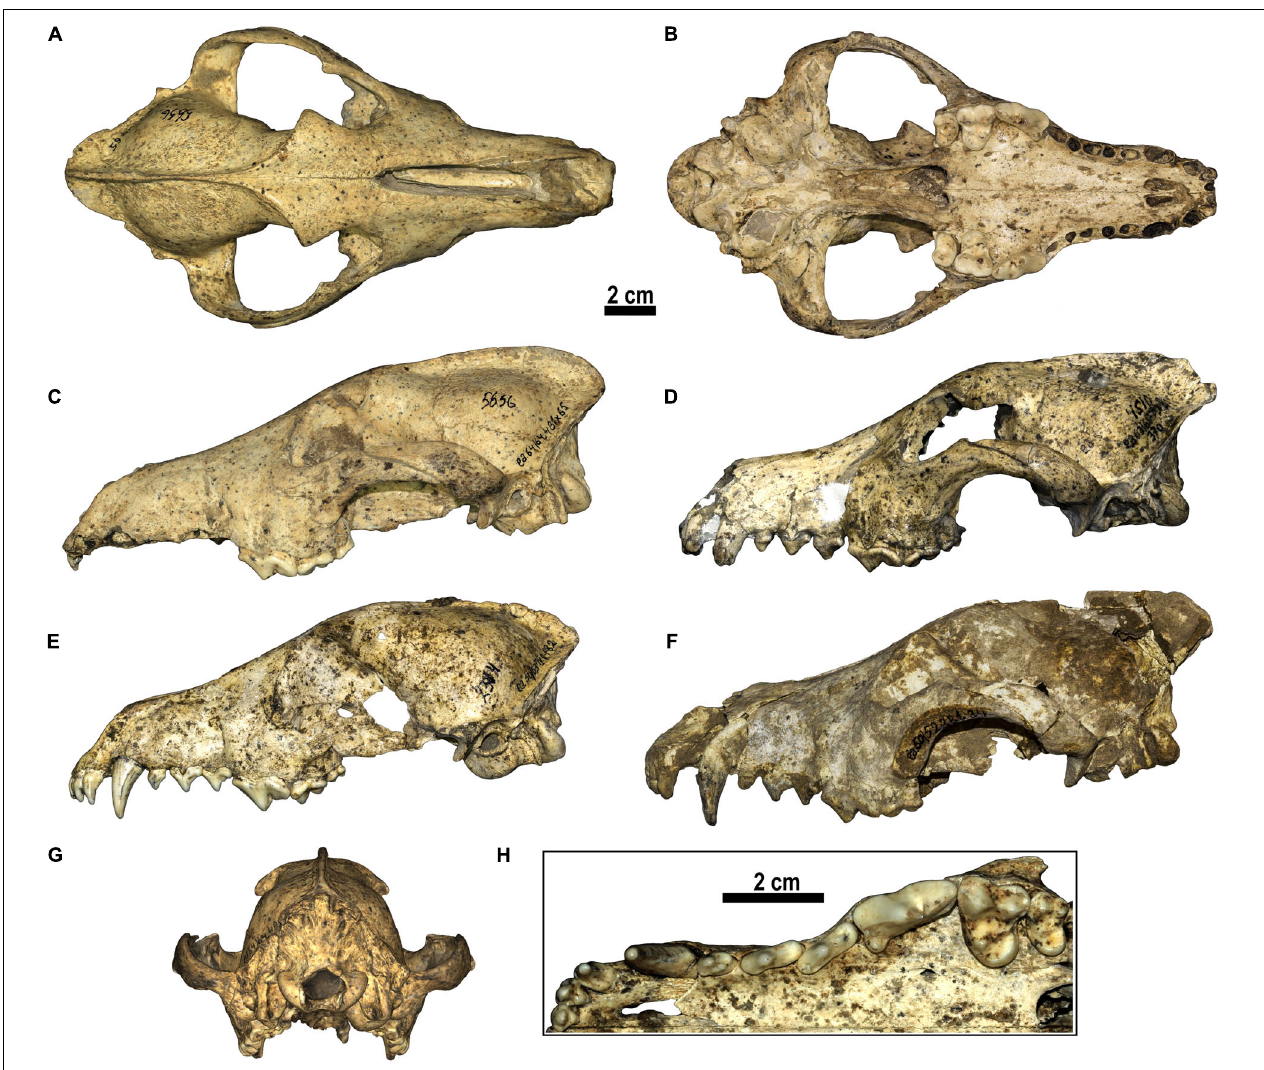
FIGURE 1 | Canis from Dmanisi. (A–C,G) D5656, cranium in (A) dorsal, (B) ventral, (C) left lateral, (G) occipital views. (D) D4510, cranium in left lateral view. (E) D2314, cranium in left lateral view. (F) Dm.50/52.3B1.34, cranium in left lateral view. (H) Detailed view of the occlusal morphology of the upper teeth of Canis from Dmanisi